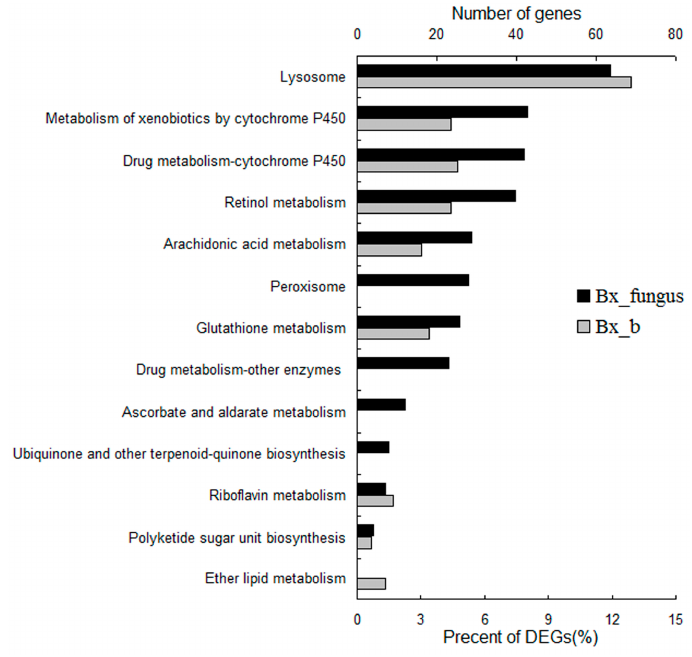
Figure 5. Relative pathways significantly enriched in differentially expressed genes (DEGs) of PWNs treated with endobacterium and fungus PWNs ( p < 0.005). DEGs were enriched in detoxification